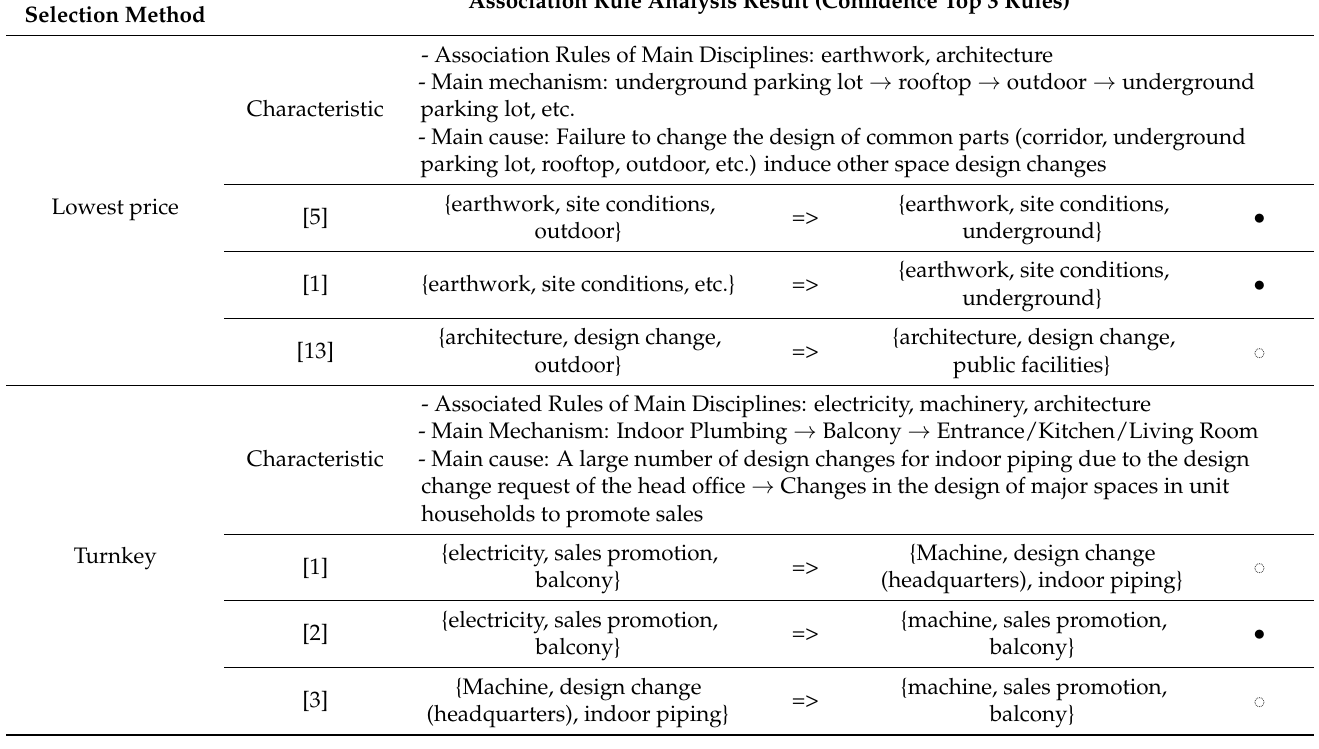
Table 3. Association rule classification system through expert